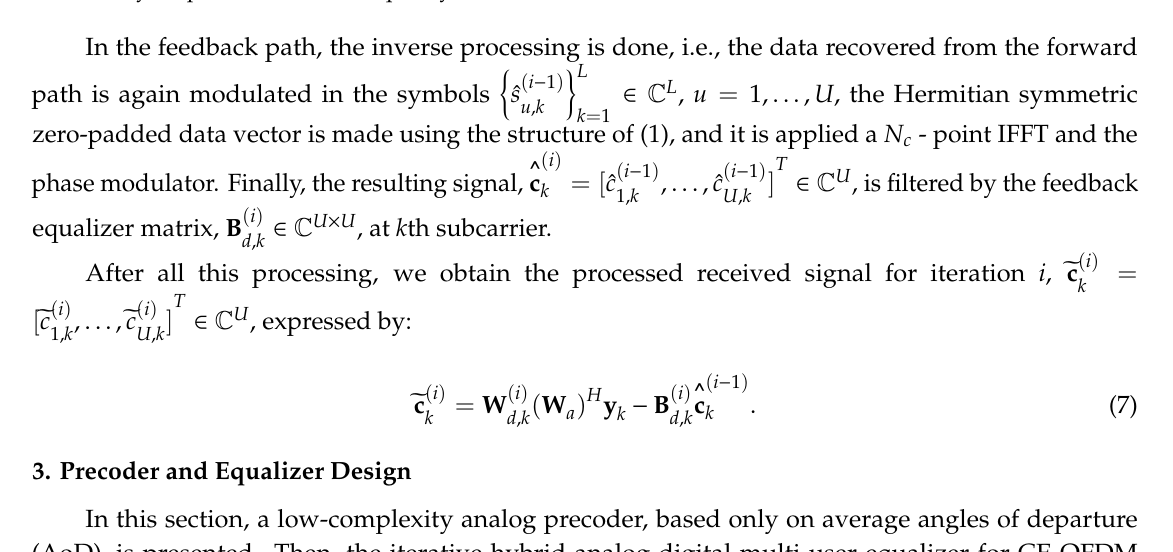
Figure 2. Proposed receiver structure. FFT: fast Fourier transform; IFFT: inverse fast Fourier transform; CP: cyclic prefix; RF: radio frequency.